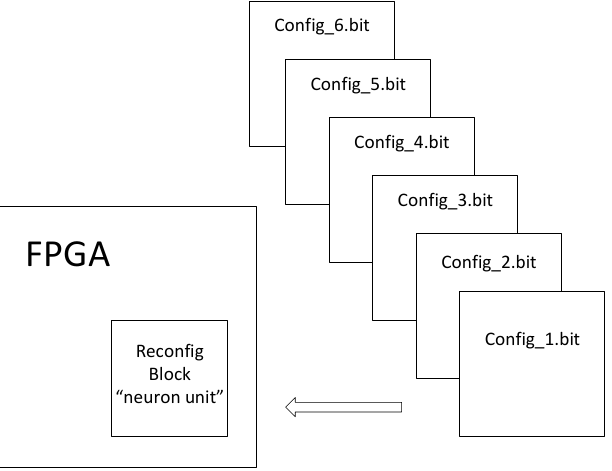
Figure 10. Illustration of Partial